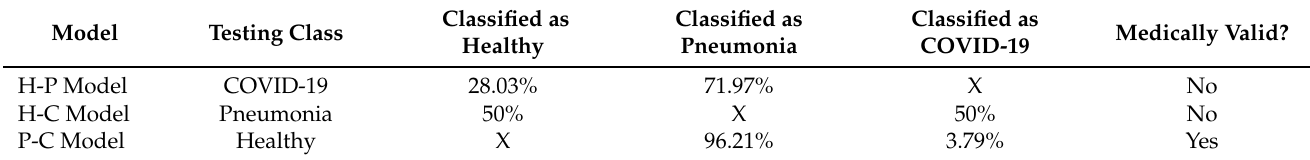
Table 5. Classification results obtained with the non-trained class for each binary model.